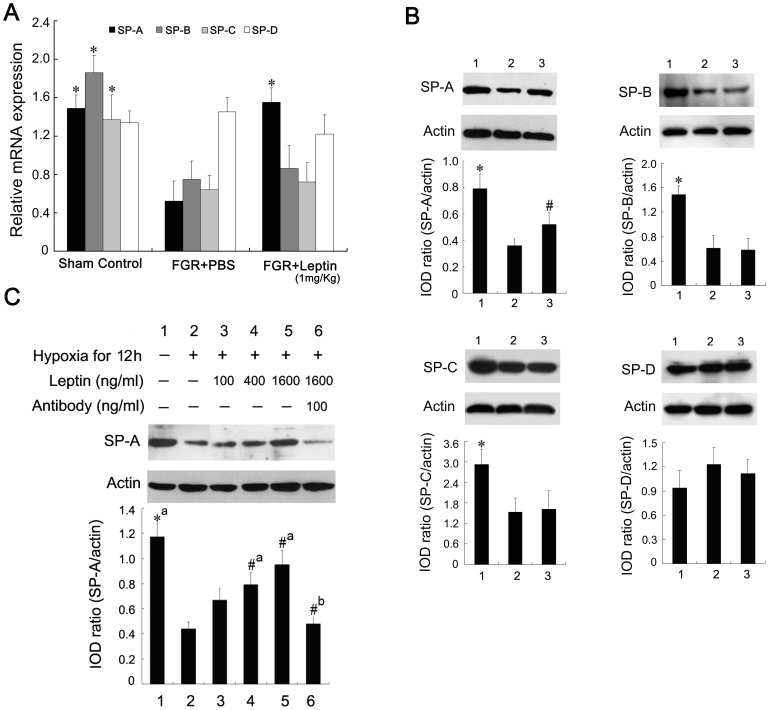
Effect of leptin on the expression of SP-A in fetal lungs and type-II AECs.A: Fetal lung tissue from the sham control group, PBS-treated FGR group, and leptin-treated FGR group were collected and total RNA was extracted for mRNA expression measurement of surfactant protein A (black), B (dark gray), C (light gray) and D (white) by quantitative real-time RT-PCR. *P<0.01 vs the PBS-treated FGR group (n = 3). B: Fetal lung tissue isolated from the sham control group (lane 1), PBS-treated FGR group (lane 2), and leptin-treated FGR group (lane 3) were subjected to western blot analysis to determine the protein levels of surfactant protein A, B, C and D, which were semi-quantified by densitometry and normalized by β-actin. Data are presented as mean ± SEM. *P<0.01, #P<0.05 vs the PBS-treated FGR group (n = 3). C: Cultured type-II AECs were exposed to normal conditions or hypoxia for 12 h with different concentrations of leptin or specific antibody against leptin. Whole lysates were detected by immunoblotting with anti-SP-A antibody. *P<0.01, #P<0.05; a: vs the hypoxia-treated group, b: vs the 1600 ng/mL leptin-treated group (n = 3).